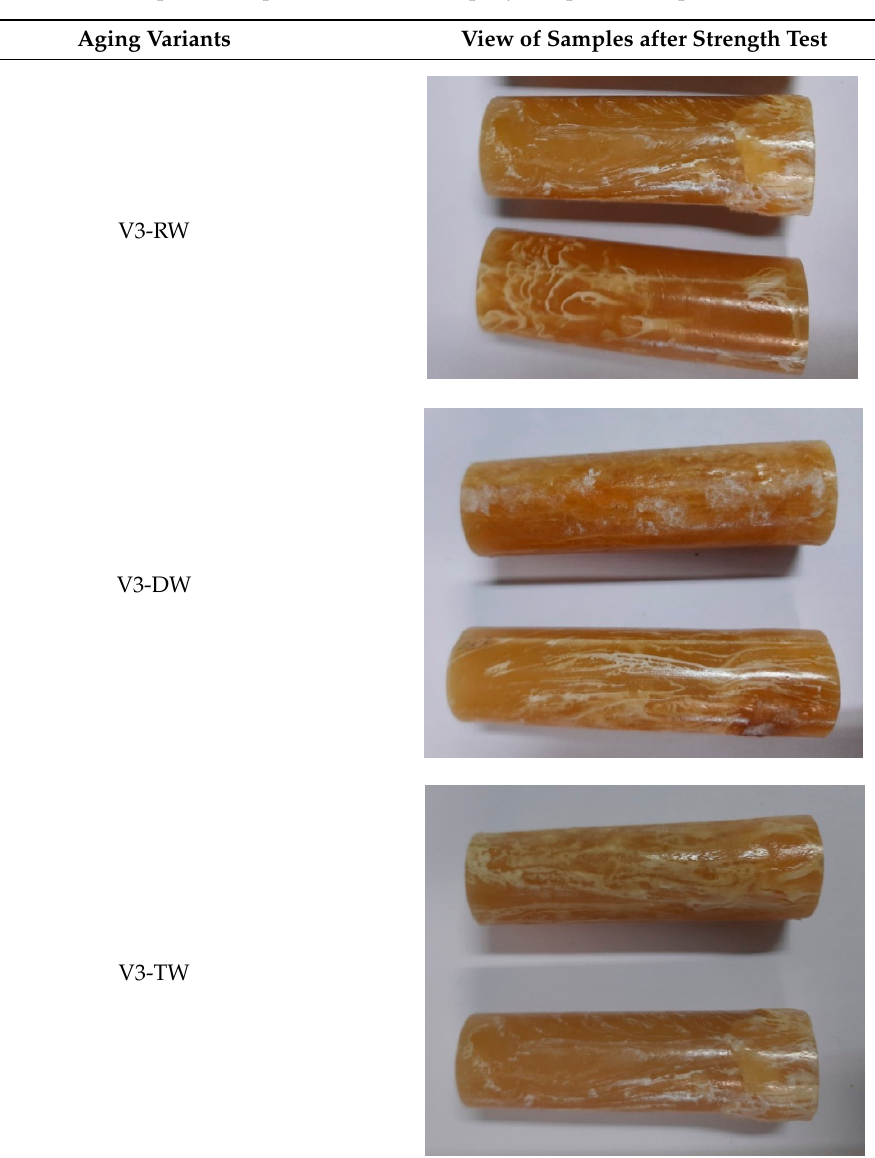
Table 10. View of the shape of the Epidian 57PAC/10:1 epoxy compound samples—variant III.